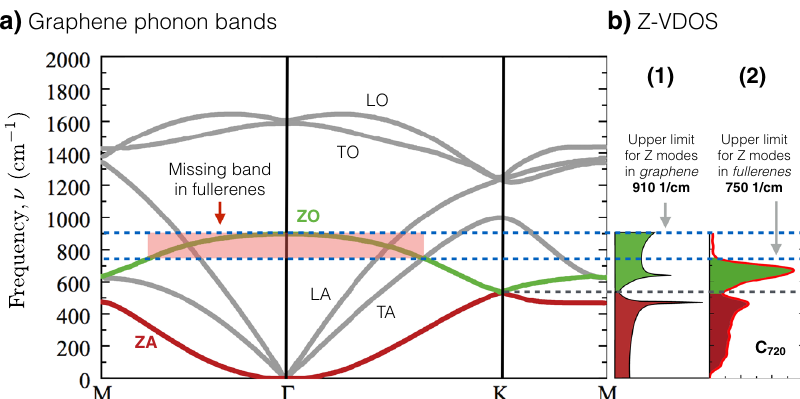
Fig. 3 Comparison of Z-phonon-bands between bulk graphene and fullerenes. a Graphene phonon bands and their mode classi fi cation. The out-of-plane (Z) phonons are highlighted in red for the acoustic band (ZA) and in green for the optical (ZO) band. b -1 ZO-band and ZA-band contribution to the graphene total VDOS. b -2 Radial (Z)-VDOS in C 720 fullerene. Graphene ’ s VDOS was taken from ref. 47 . The missing frequency region of the ZO-bulk- analog phonons missing in the fullerene family is shadowed in a and highlighted by dashed lines.